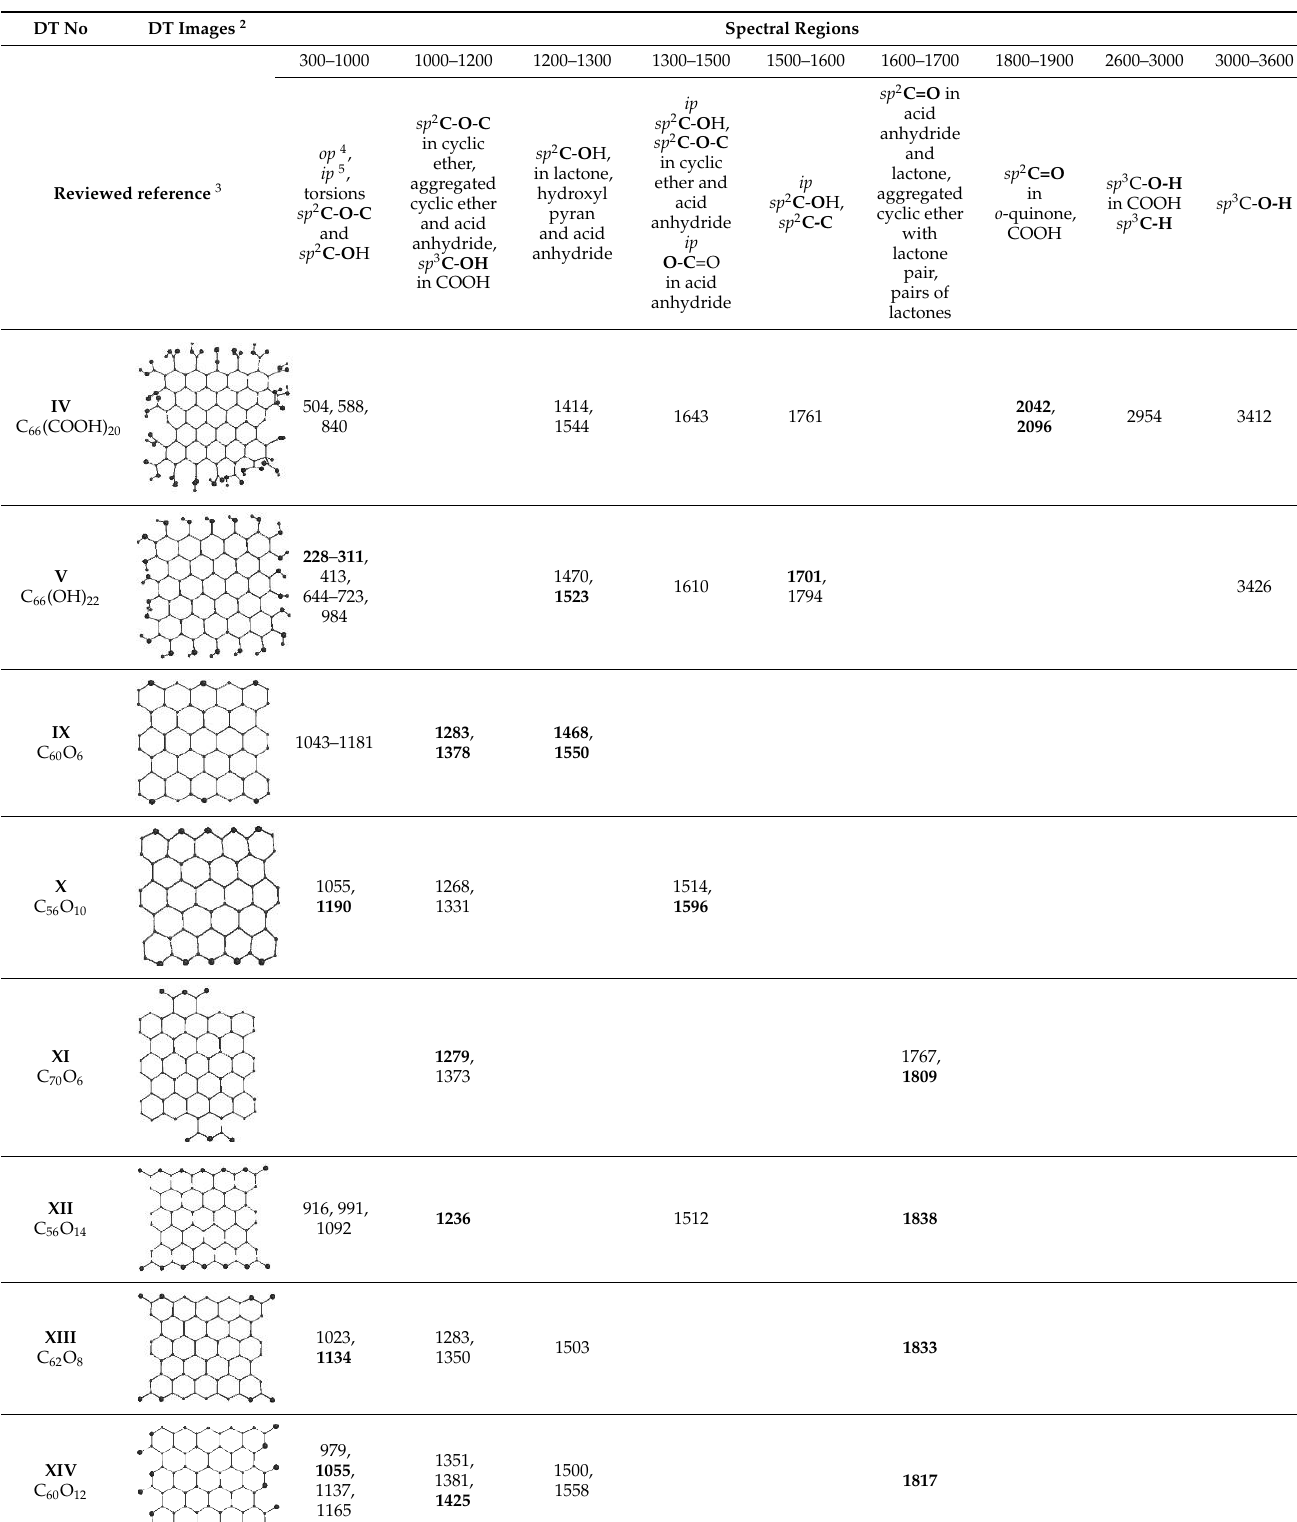
Table 2. UHF general frequencies kits of necklaced graphene oxides, based on IR spectra 1 , cm −1 . DT